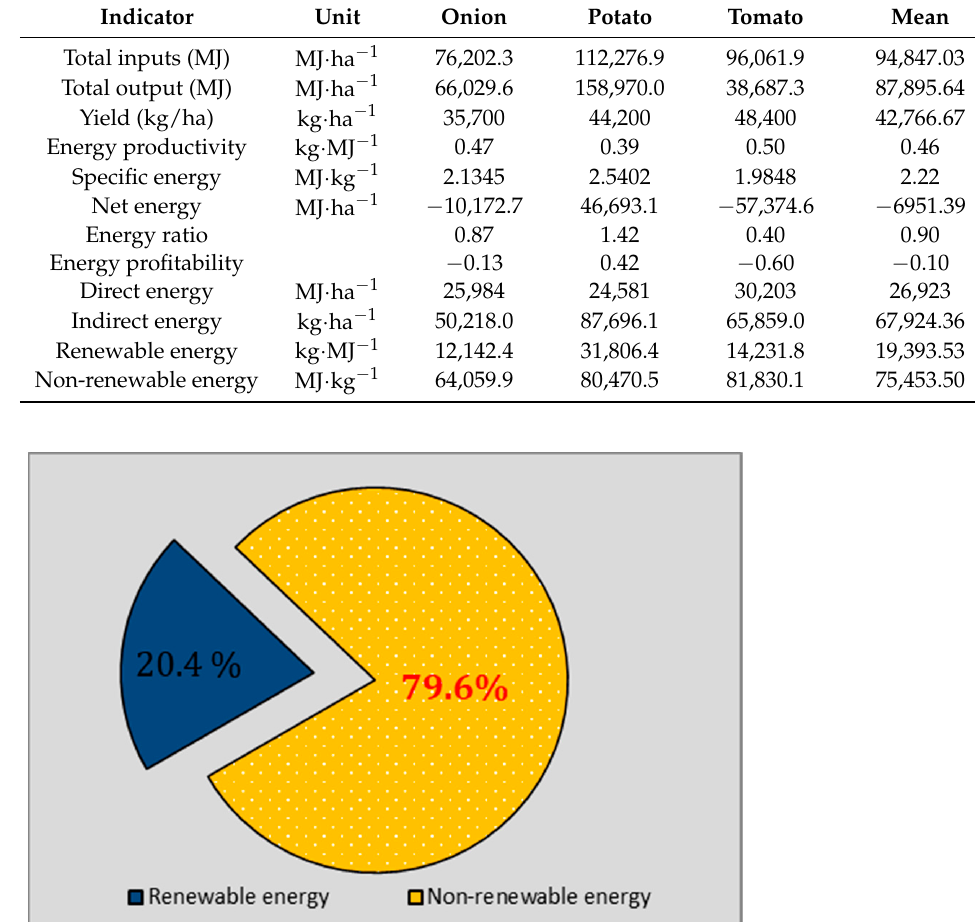
Table 3. Energy forms and indices of production processes of vegetable crops.